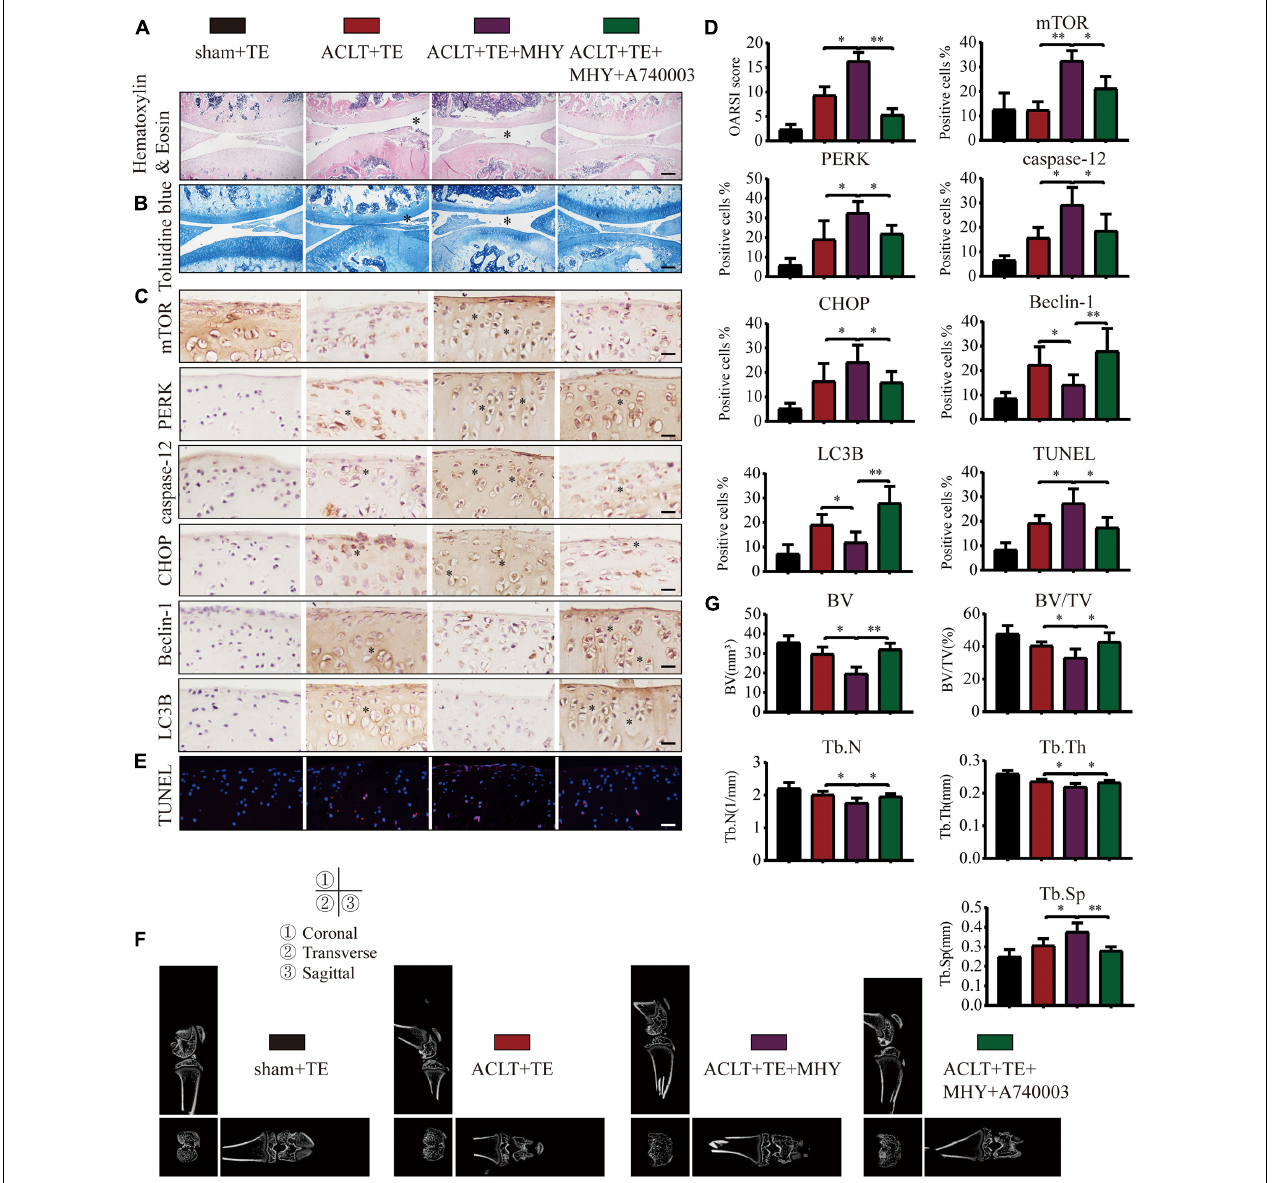
FIGURE 9 | mTOR activation inhibits autophagy, induces apoptosis, and increases cartilage loss. The sagittal sections of knee joints were stained with H&E (A) and TB (B) at 4-week time point (scale bar: 500 µ m). The degree of cartilage loss and matrix degradation was quantified using the OARSI scoring system; data are presented on the right. (C,D) IHC staining and quantification of mTOR, PERK, caspase-12, CHOP, LC3B, and Beclin-1 was performed to observe changes in the expression levels of these indicators after the intra-articular injections of rapamycin and Bz-ATP (scale bar: 200 µ m). (E) TUNEL staining was performed to quantify the number of apoptotic chondrocytes in each group (scale bar: 200 µ m). (F) The knee joints in each group were evaluated using micro-CT, and the imaging data of the tibial plateau and subchondral bone were obtained (scale = 1 mm). (G) Quantification of micro-CT bone-related parameters, including BV, BV/TV, Tb.N, Tb.Th, and Tb.Sp. The asterisk in the HE and TB staining images represents the cartilage damage site, and the asterisk in the histochemical images represents the positively stained cells. Data are expressed as means ± standard deviations of at least three independent experiments. ∗ p < 0.05, ∗∗ p <